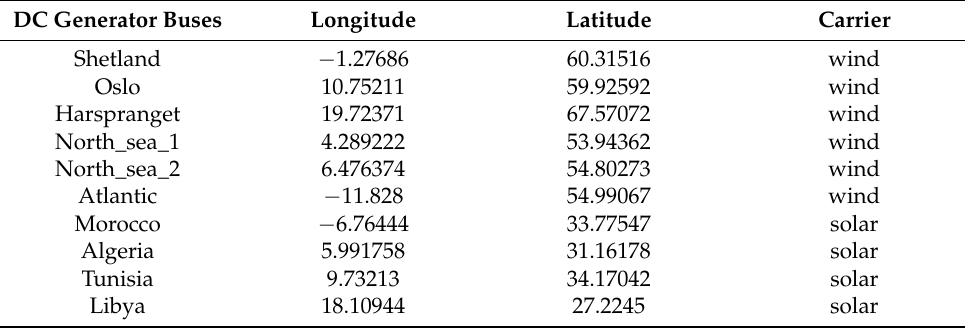
Table A1. DC generation